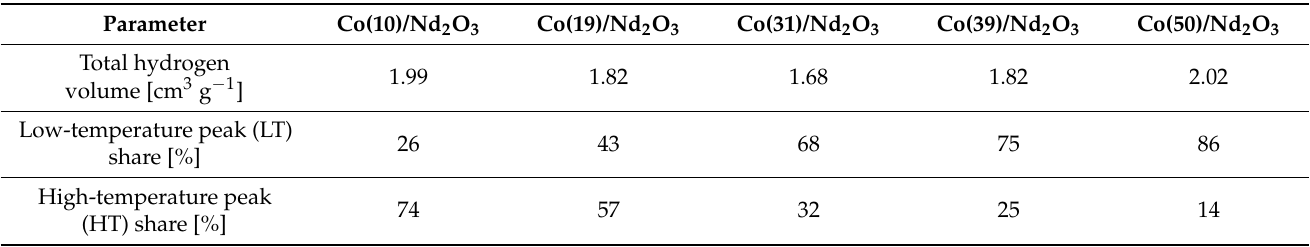
Table 3. Comparison of average Co particle and Co crystallite size in the Co/Nd 2 O 3 catalysts, determined through H 2 -TPD, XRPD and TEM.